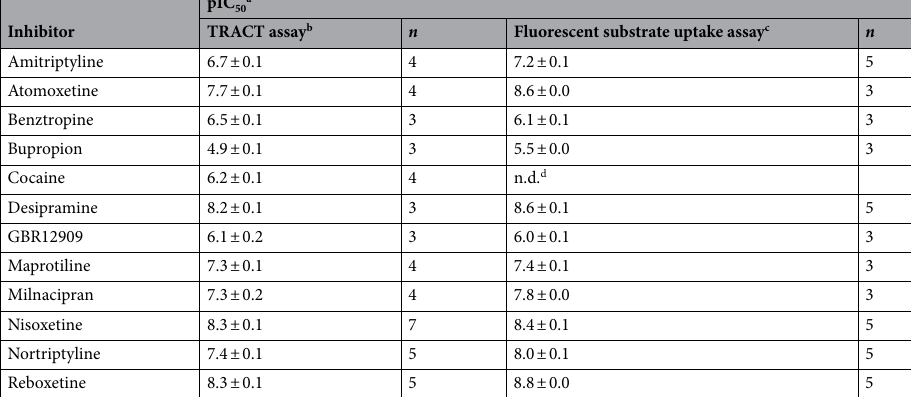
Table 2. Inhibitory potency (pIC 50 ) values of NET inhibitors determined in the TRACT assay and fluorescent substrate uptake assay. a The mean pIC 50 values found in the TRACT assay were on average 0.3 log-units lower than in the fluorescent substrate uptake assay ( p = 0.016, paired two-tailed Student’s t-test). b In the TRACT assay, values are reported as the mean ± SEM of three to seven individual experiments performed in duplicate. c In the fluorescent substrate uptake assay the values are reported as the mean ± SEM of three to five individual experiments each performed in quadruplicate. d Not